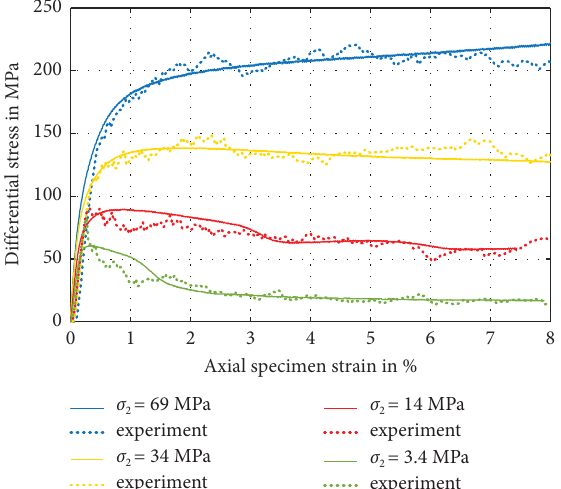
Figure 5: Simulated and measured results of triaxial compression tests on Danby